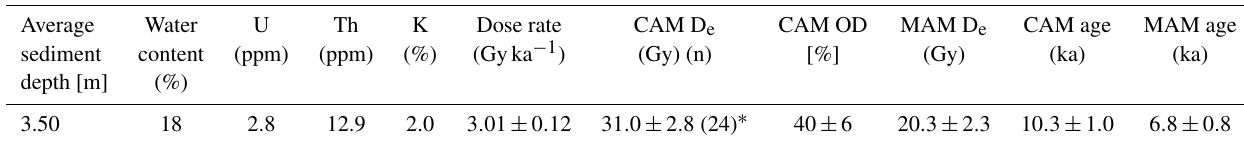
a and b Samples that are too old and too young, respectively. Table 3. Equivalent dose measurements on sample VOV16-1. 24 aliquots were measured ( ∗ n = number of aliquots, a 25th aliquot with a D e of ∼ 125Gy was excluded prior to